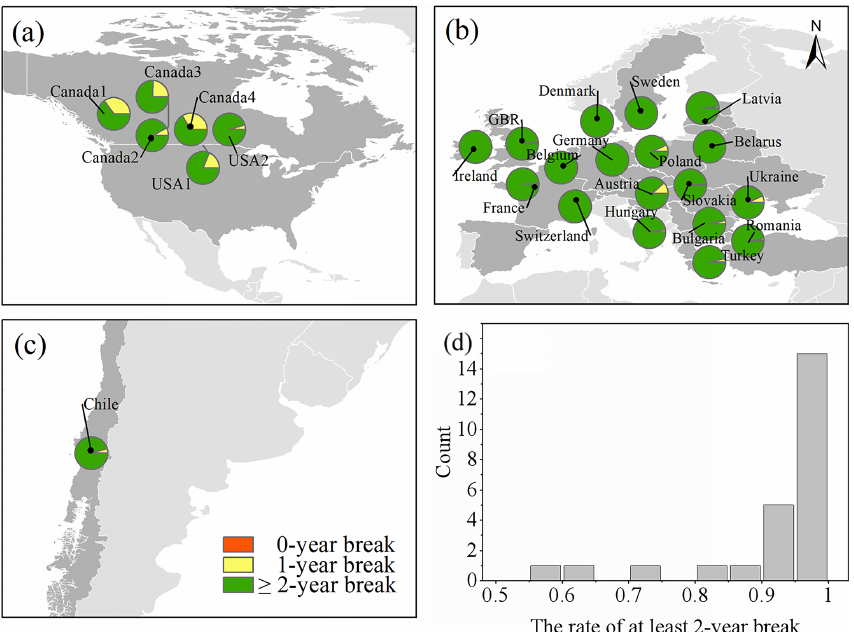
Figure 12. Rapeseed crop rotation. (a) – (c) Proportions of rapeseed planting areas subjected to rotation breaks of 0, 1, or ≥ 2 years. (d) The number of areas in (a) – (c) subjected to breaks of at least 2 years.